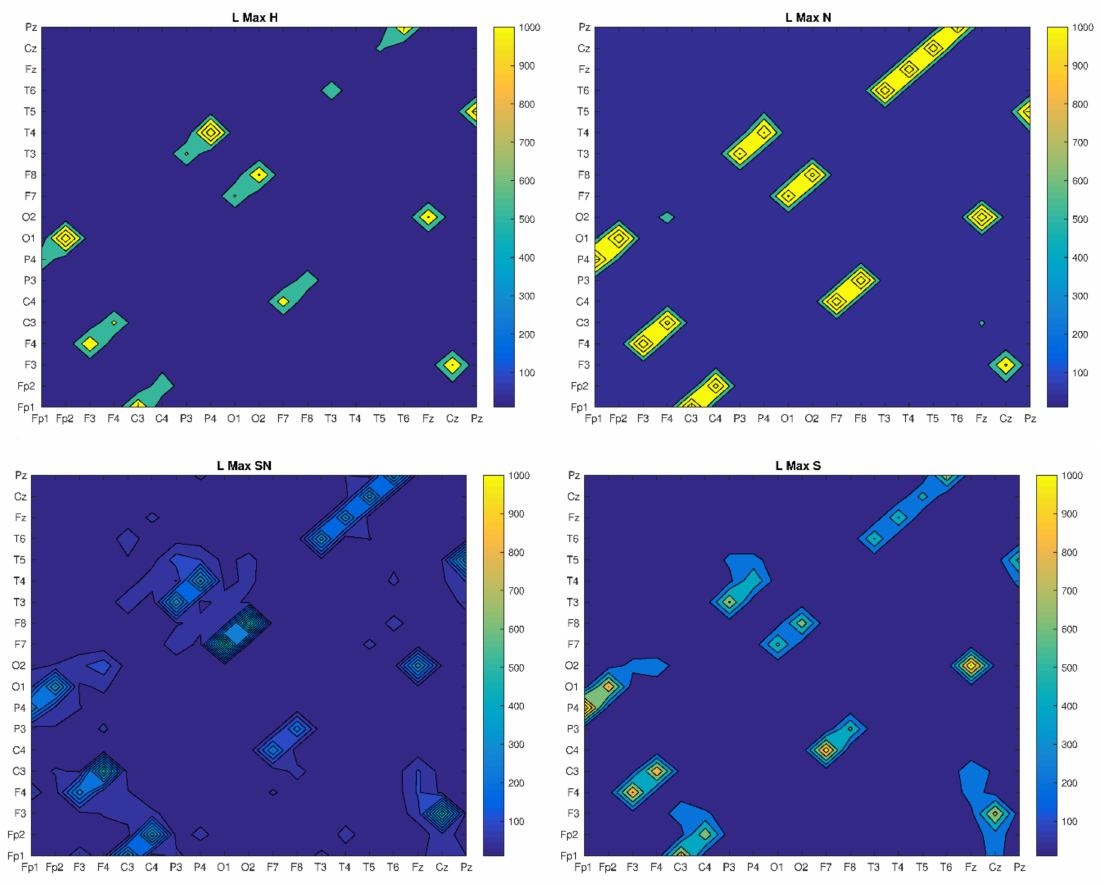
Figure 5. The Maximal length of diagonal lines of four trails for all bands: H, N, SN and S,